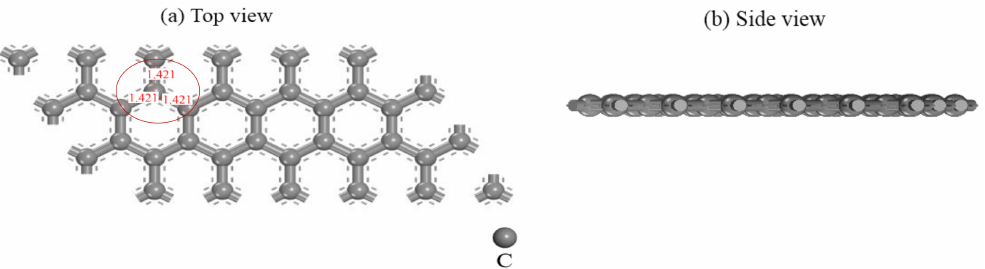
Figure 2. Configuration of the graphite surface after optimization.